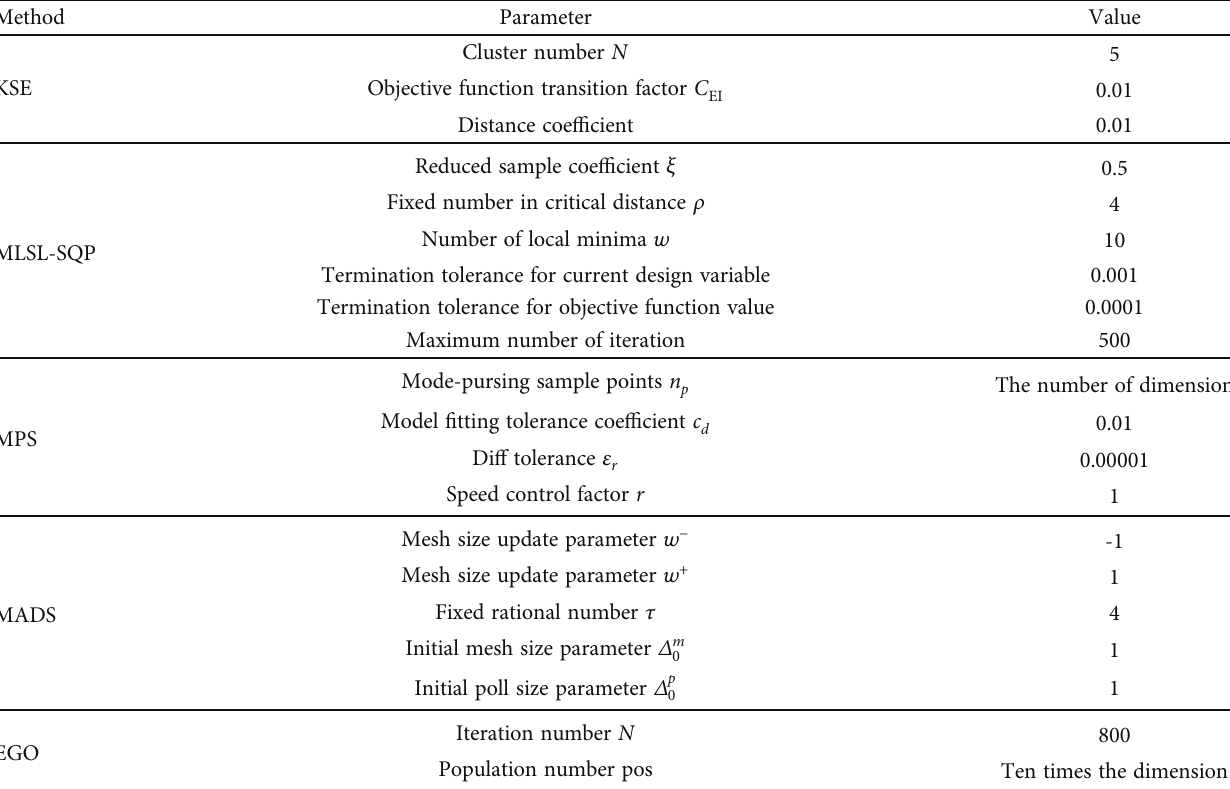
Table 2: Parameter setting of KSE